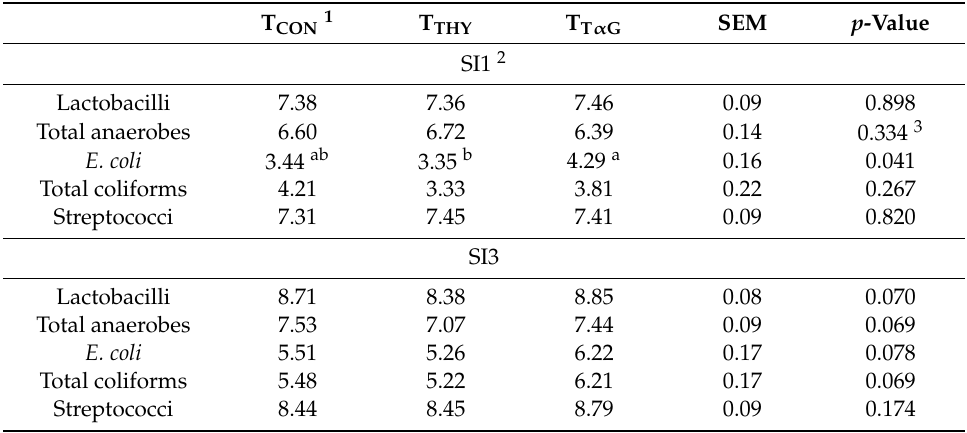
Table 4. The e ff ect dietary treatment on bacterial counts (log 10 CFU / g) in the small intestine of piglets between 13 and 15 days post-weaning.